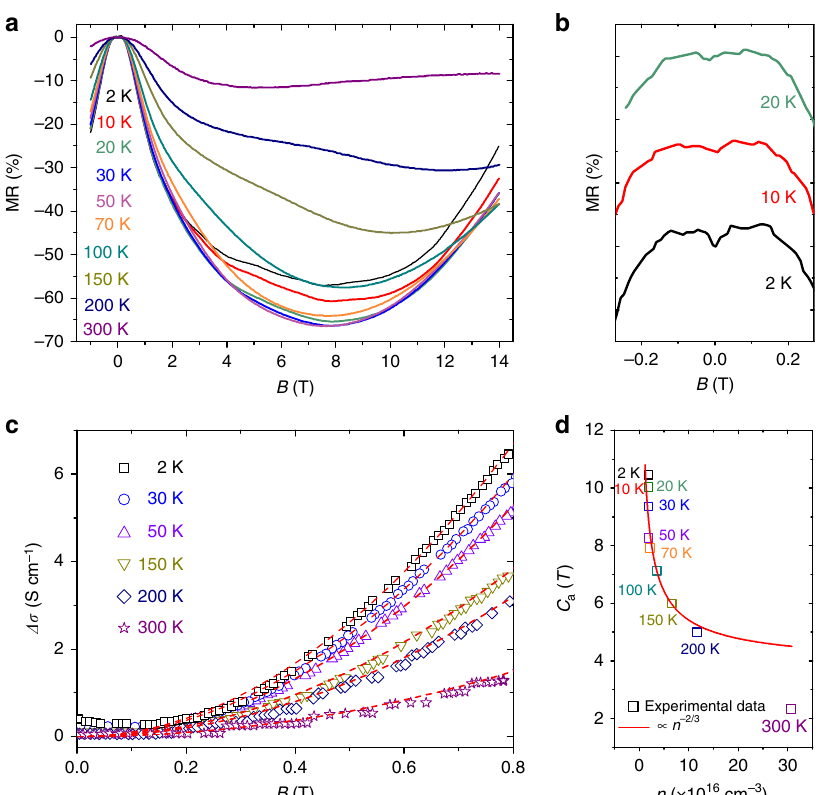
Figure 4 | Negative MR in B parallel to E . ( a ) The MR measured at different T indicated. ( b ) The weak anti-localization effect at low temperatures and very small magnetic fields. ( c ) The positive conductivity D s ¼ s – s 0 , where s 0 is the conductivity at B ¼ 0, converted from measured negative MR at different T indicated. The solid red curves are the fittings using D s ¼ C a B 2 . (d) C a as a function of the carrier density, n . The solid red curve is a fitting using n (cid:3) 2/3 . The corresponding temperature for each data point is also